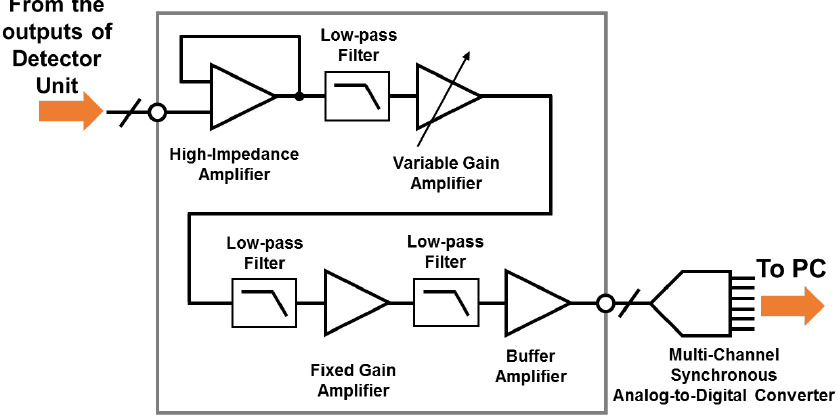
Figure 3. Block diagram of the the amplifier chain and interface from a detector unit to an analog-to-digital converters (ADC) in the signal conditioning block.